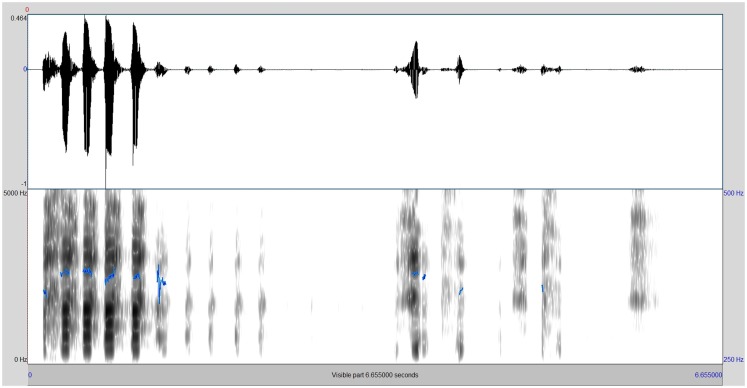
Spectrogram of the vocal laughter stimulus being perceived as least malicious by the gelotophobes.